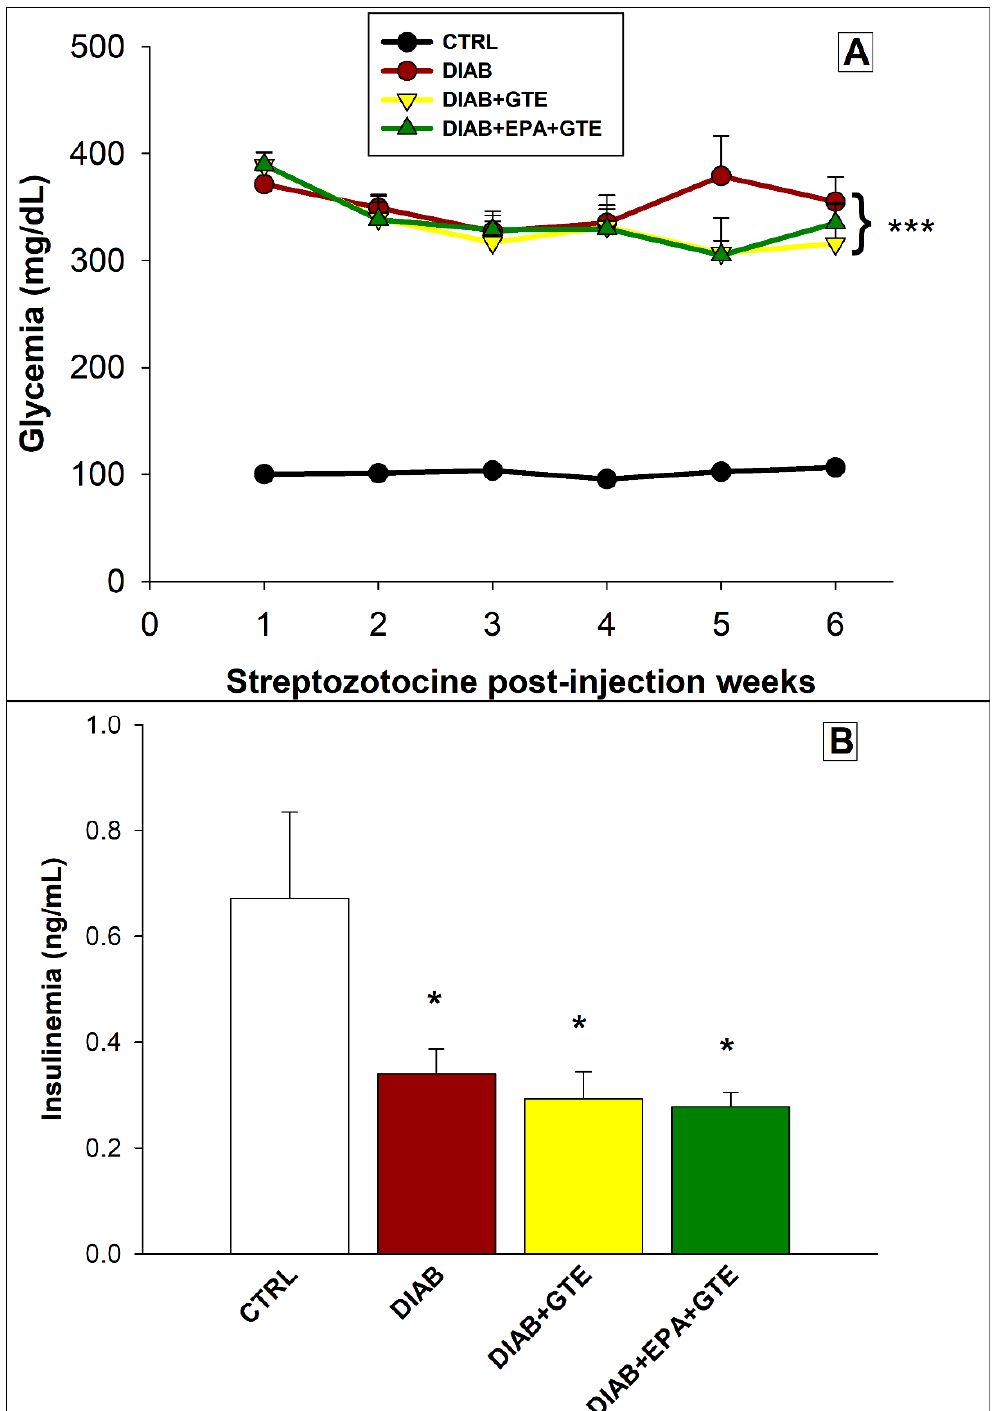
Figure 1. Glycemia and insulinemia. ( A ) Glycemia after the streptozotocin injection and ( B ) Insulinemia on the day of euthanasia. CTRL: Control group; DIAB: Diabetic rats; GTE: Green tea extract enrichment; and EPA: Eicosapentaenoic acid enrichment. *: Di ff erent to the CTRL group. One symbol: p < 0.05; two symbols: p < 0.01; and three symbols: p <